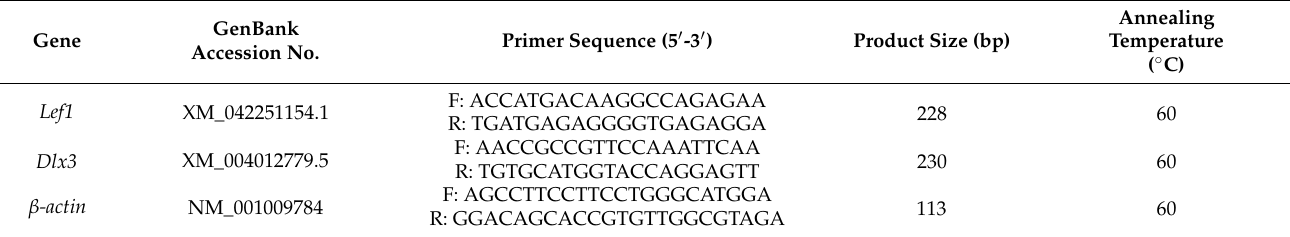
Table 1. Primer sequences and annealing temperatures used for